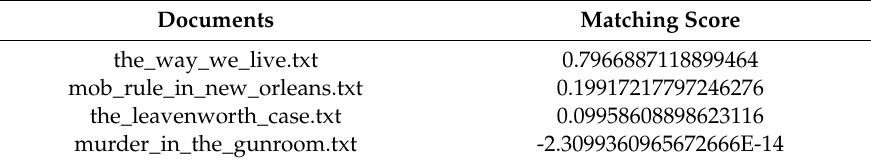
Table A6. Top Docs for TermQuery: prison, kill, and destroy.